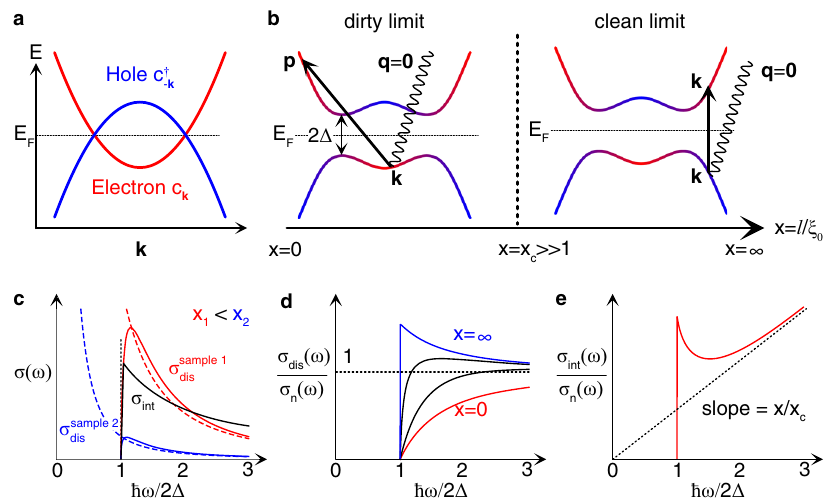
Fig. 1 Dirty and clean optical responses. a Band structure in the Bogoliubov de-Gennes (BdG) formalism. Superconducting pairing opens the bandgap at the Fermi level E F by mixing electron (red) and hole (blue) bands as shown in ( b ). c k and c y (cid:2) indicate the electron and hole annihilation operators, k respectively. b Optical excitations in dirty and clean limits by spatially uniform light ( q = 0 ) across the superconducting gap 2 Δ . The momentum transfer p − k in the left fi gure is supplied from the impurity potential. The crossover from dirty to clean optical responses occurs when the mean free path l exceeds ¼ ð k ξ Þ 2 α (cid:2) 2 . Here, k α is a degree of multiband pairing (see the the superconducting coherence length ξ 0 by a factor x F is the Fermi wave number, and c F 0 text above Eq. (6) for its more precise de fi nition). The red and blue colors schematically represent the electron – hole band mixing in the superconducting state. c Real part of the optical conductivity in clean systems ( x > 1). σ s = σ dis + σ int in the superconducting state is the sum of disorder-mediated and intrinsic parts. σ int ∝ ω − 1 is insensitive to x while σ dis ∝ x − 1 ω − 2 depends signi fi cantly on x . The Drude conductivity in the normal state σ n is also shown as dashed lines. d , e Ratio of superconducting and normal state conductivities. d Disorder-mediated part. e Intrinsic